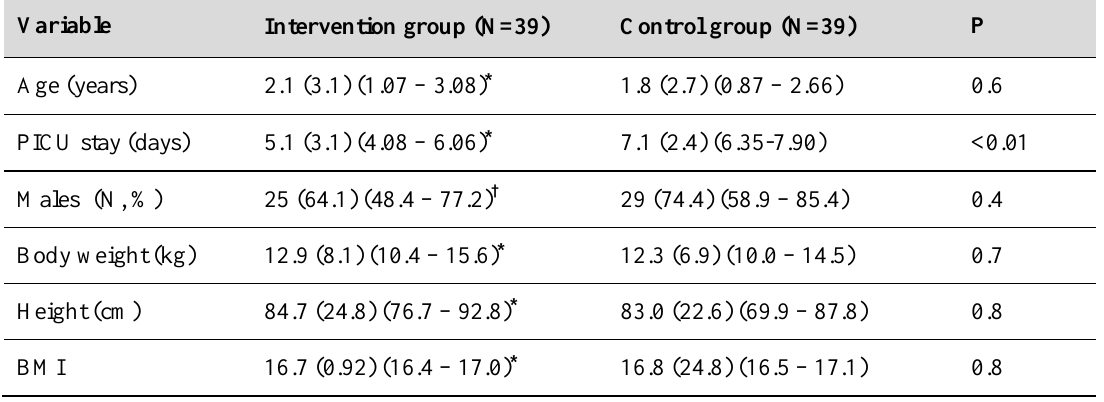
Table 1. Baseline characteristics in the ITT